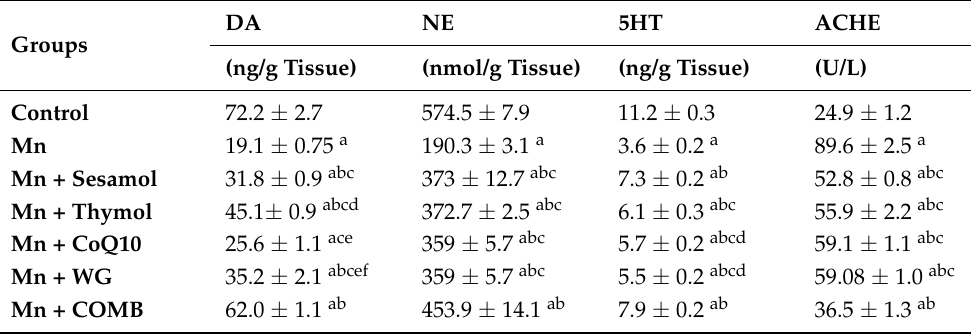
Table 1. Effect of sesamol, thymol, CoQ10, WG, or their combination on MnCl2-induced changes in brain monoamine levels and ACHE activity.